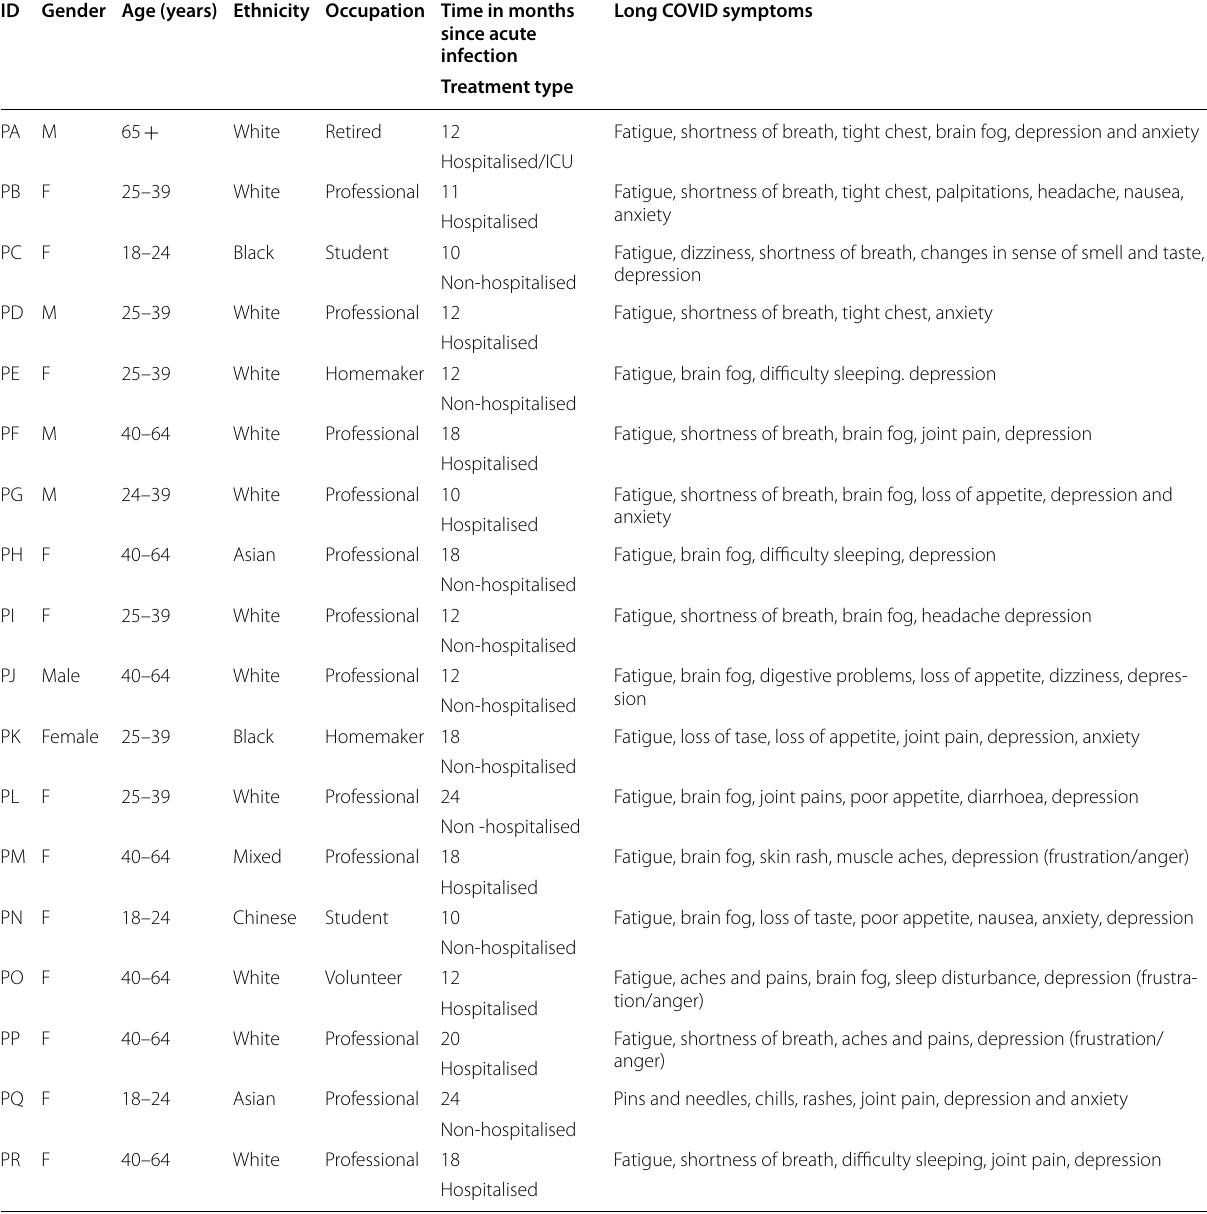
Table 1 Participant characteristics (n ID Gender Age (years) Ethnicity Occupation Time in months